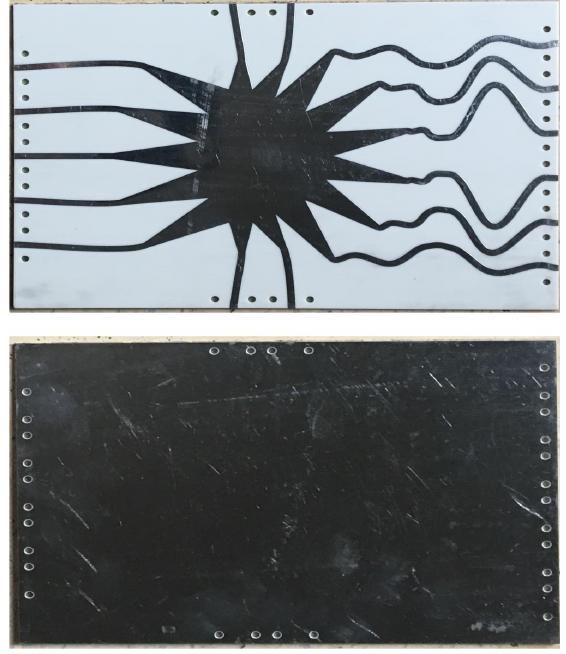
Figure 3. Realized prototype of the proposed Rotman lens sensor—front and back view.